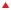
Non-metric multidimensional scaling (nMDS) plot comparing the fingerprint of pigs (n = 4 per treatment) fed the HF and LF diet for seven weeks using chip-based capillary electrophoresis data.HF, high-fat/low-fiber (▲); LF, low-fat/high-fiber (▲). Data were standardized (%) but untransformed prior to the use of the Bray–Curtis similarity algorithm. A 2D stress value of 0.17 indicates that there is no real prospect of misinterpretation. See S2 Table for identification of sample numbers.